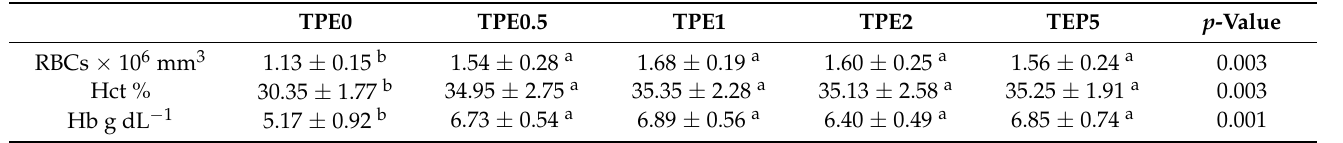
Table 4. Hematological parameters of common carp fed with experimental diets supplemented with different ratios of tomato paste by ‐ product extract (TPE).